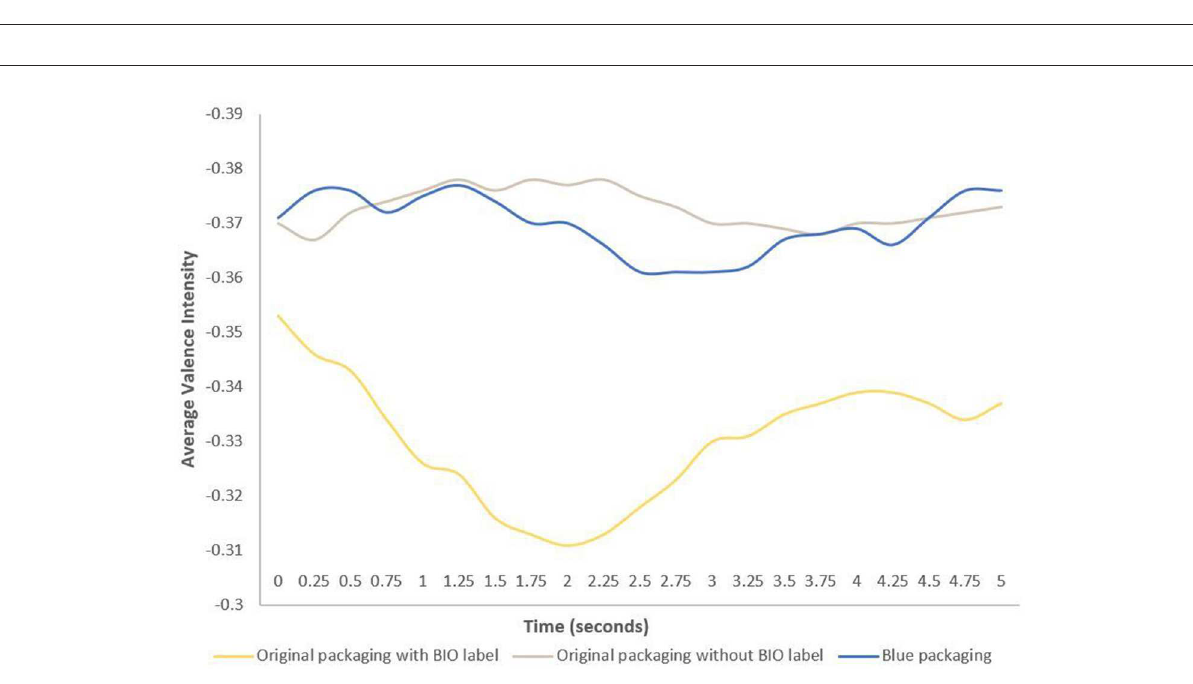
FIGURE8 Average emotional valence intensity when looking at